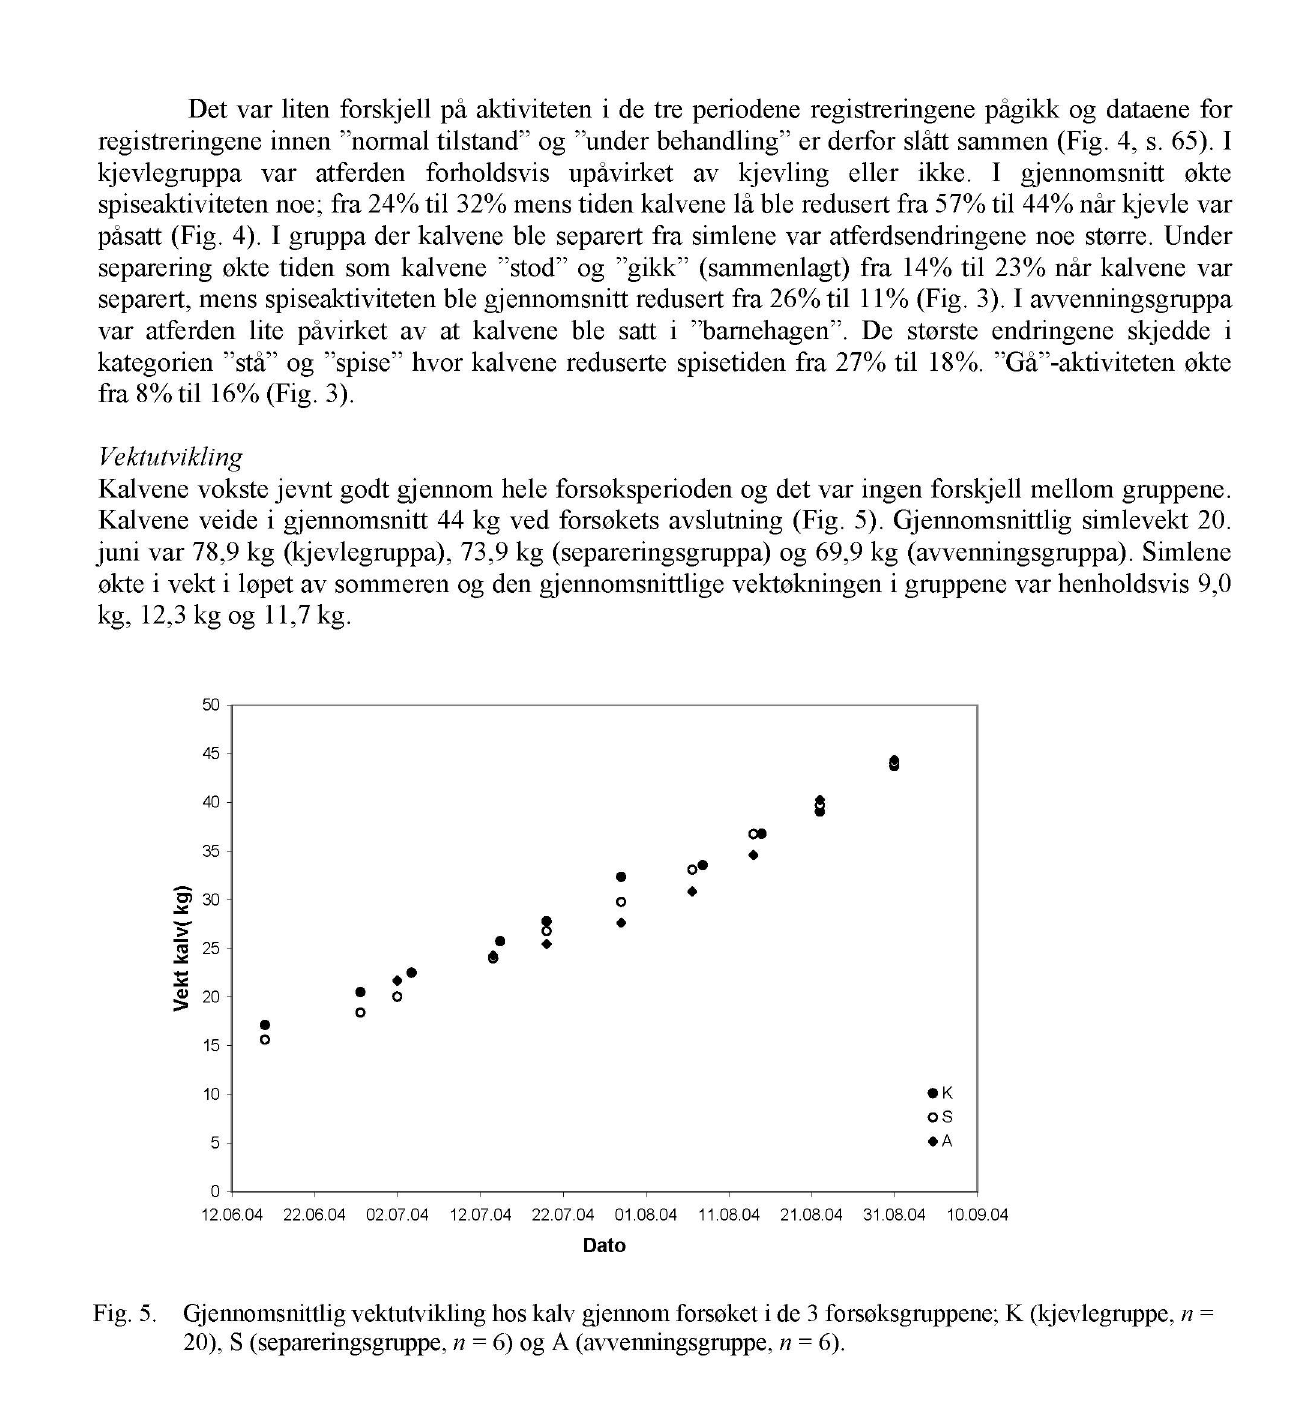
Fig. 5. Gjennomsnittlig vektutvikling hos kalv gjennom forsøket i de 3 forsøksgruppene; K (kjevlegruppe, n = 20), S (separeringsgruppe, n = 6) og A (avvenningsgruppe, n =